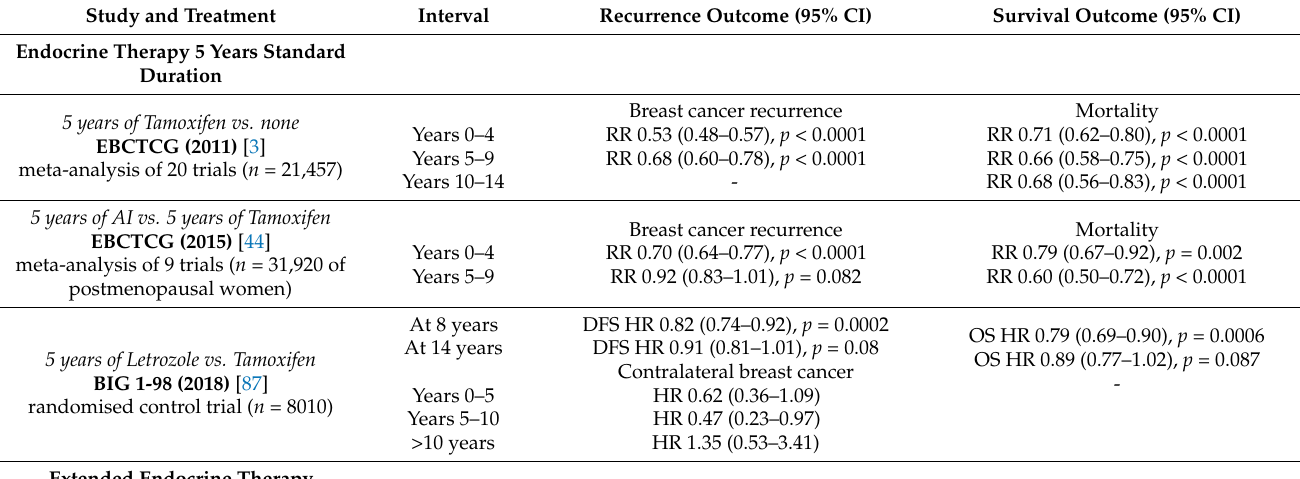
Table 2. Summary of key clinical trials, systemic reviews, and meta-analyses that investigated the role of adjuvant endocrine therapy in breast cancer ER+ HER2 −